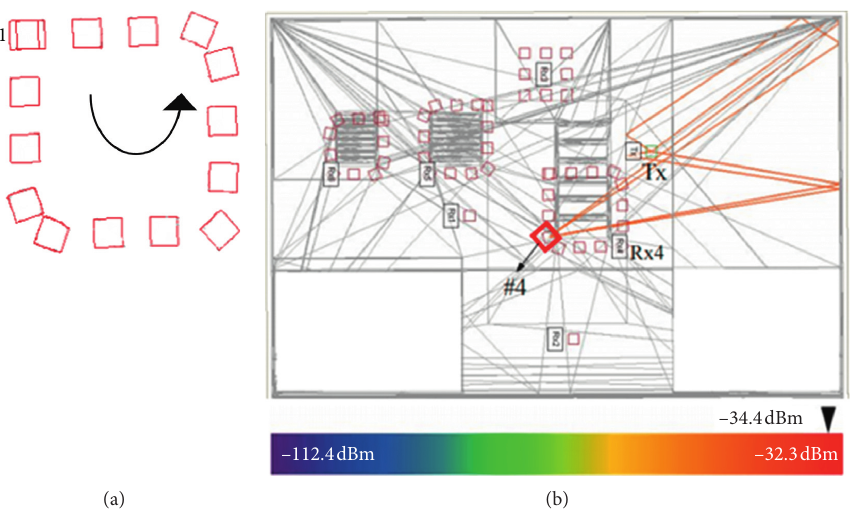
Figure 6: Simulated results of the Rx4 receiver. (a) Node deployment of Rx4. (b) A few transmission paths of the #4 node of Rx4.